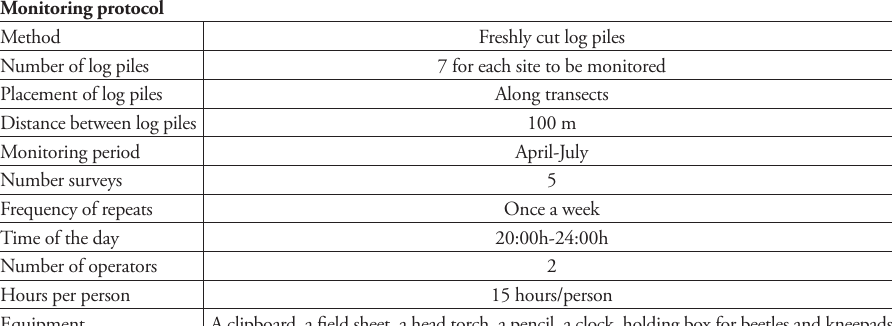
Table 1. Summary of the monitoring